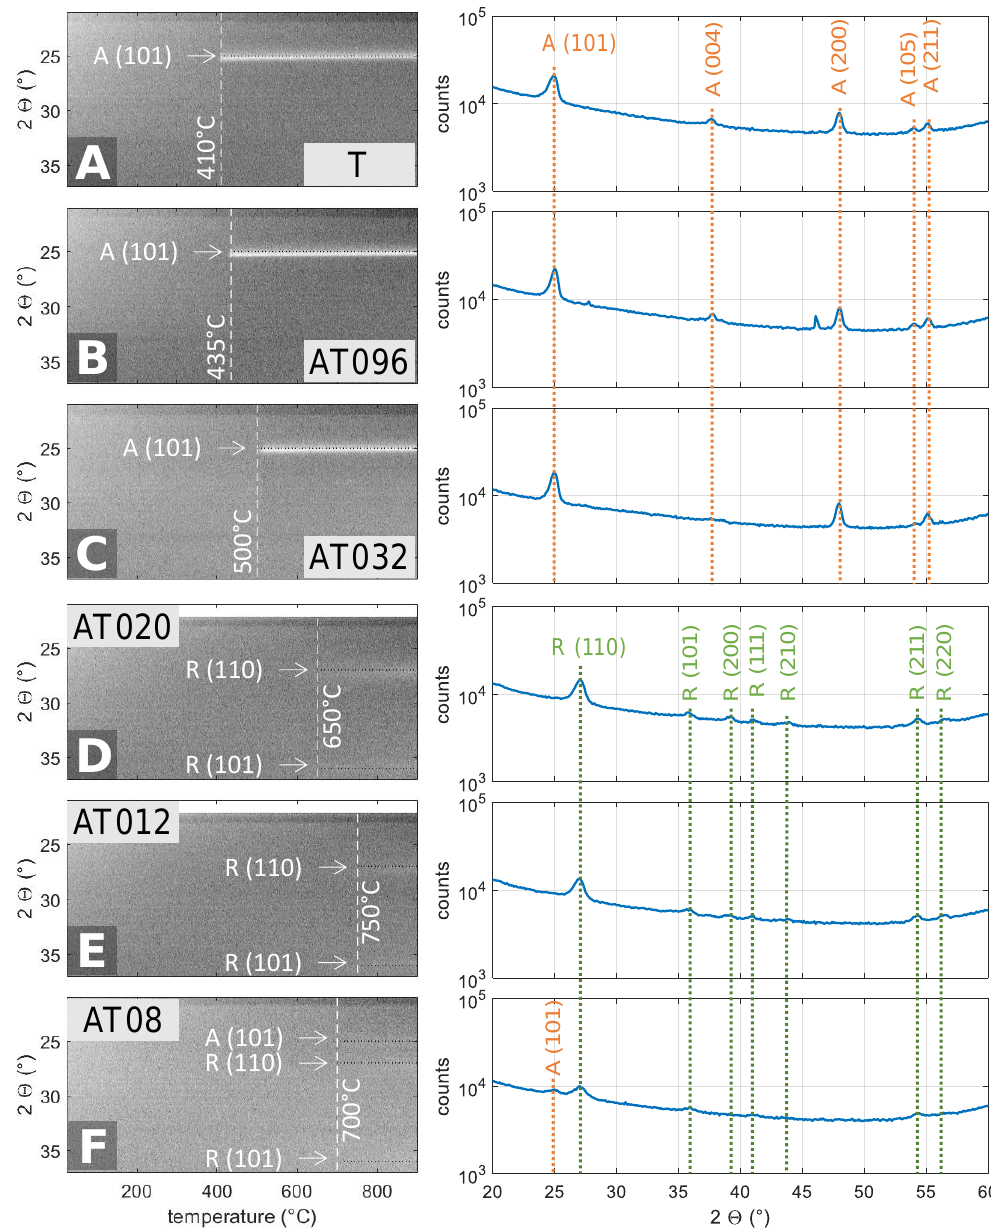
Figure 3. XRD in situ measurements from RT up to 900 °C (0.25°C/s) and full-range measurements after reaching the final temperature. Phases and the respective planes for each peak are shown, where ‘A’ stands for anatase (PDF 01-070-8501) and ‘R’ for rutile (PDF 01-072-7374). Estimated aluminum oxide content is ( a ) 0%, ( b ) 5%, ( c ) 14%, ( d ) 21%, ( e ) 32%, and ( f ) 42%, respectively. To enhance visualization, only selected compositions are shown. Please note that the axes have slightly different ranges for (a,b,c,f) and (d,e). For a full version, please refer to Figure S3.